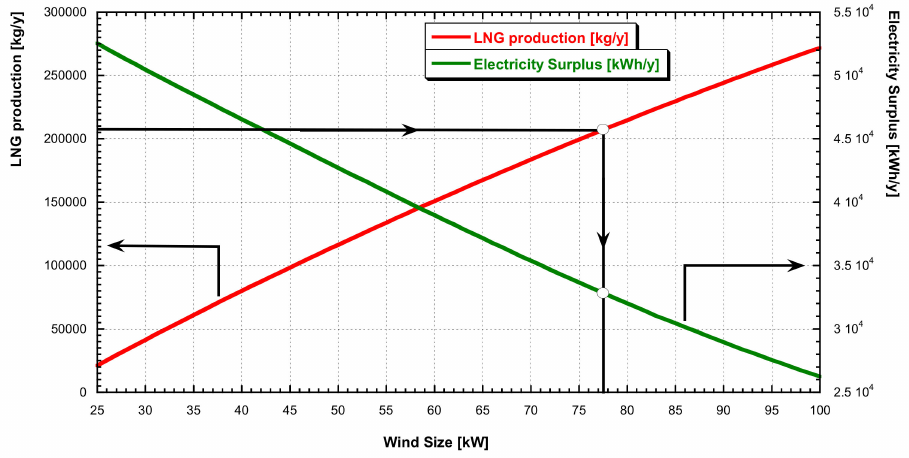
Figure 9. Yearly LNG production and energy surplus (to be sold to the grid) as a function of the wind